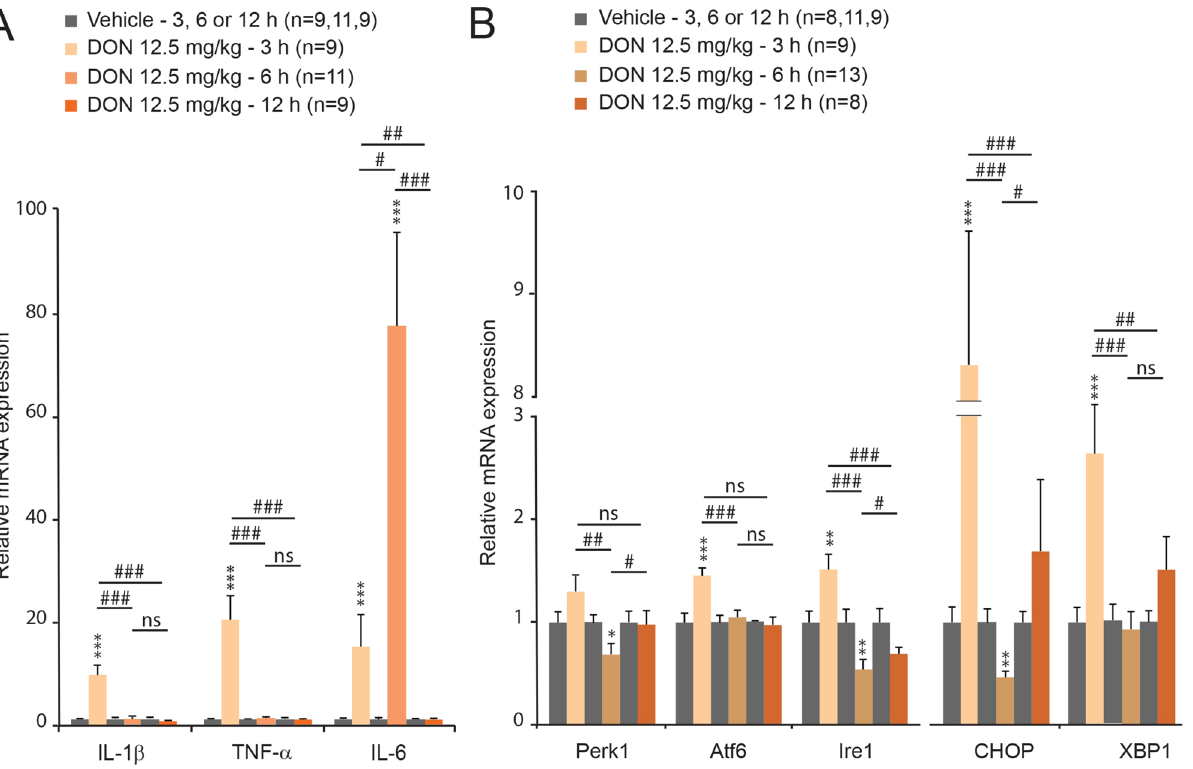
Figure 7. The expression of pro-inflammatory cytokines ( A ) and ER stress related genes ( B ) was measured by qRT-PCR from the livers of control and DON-challenged animals for the indicated times. A two-way analysis of variance test was performed between time series (3, 6 and 12 h) of DON-treated and untreated mice. * P < 0.05, ** P < 0.01 and *** P < 0.001 significantly different from control mice. # P < 0.05, ## P < 0.01 and ### P < 0.001 significant difference between time point of DON-treated mice. ns: no significant